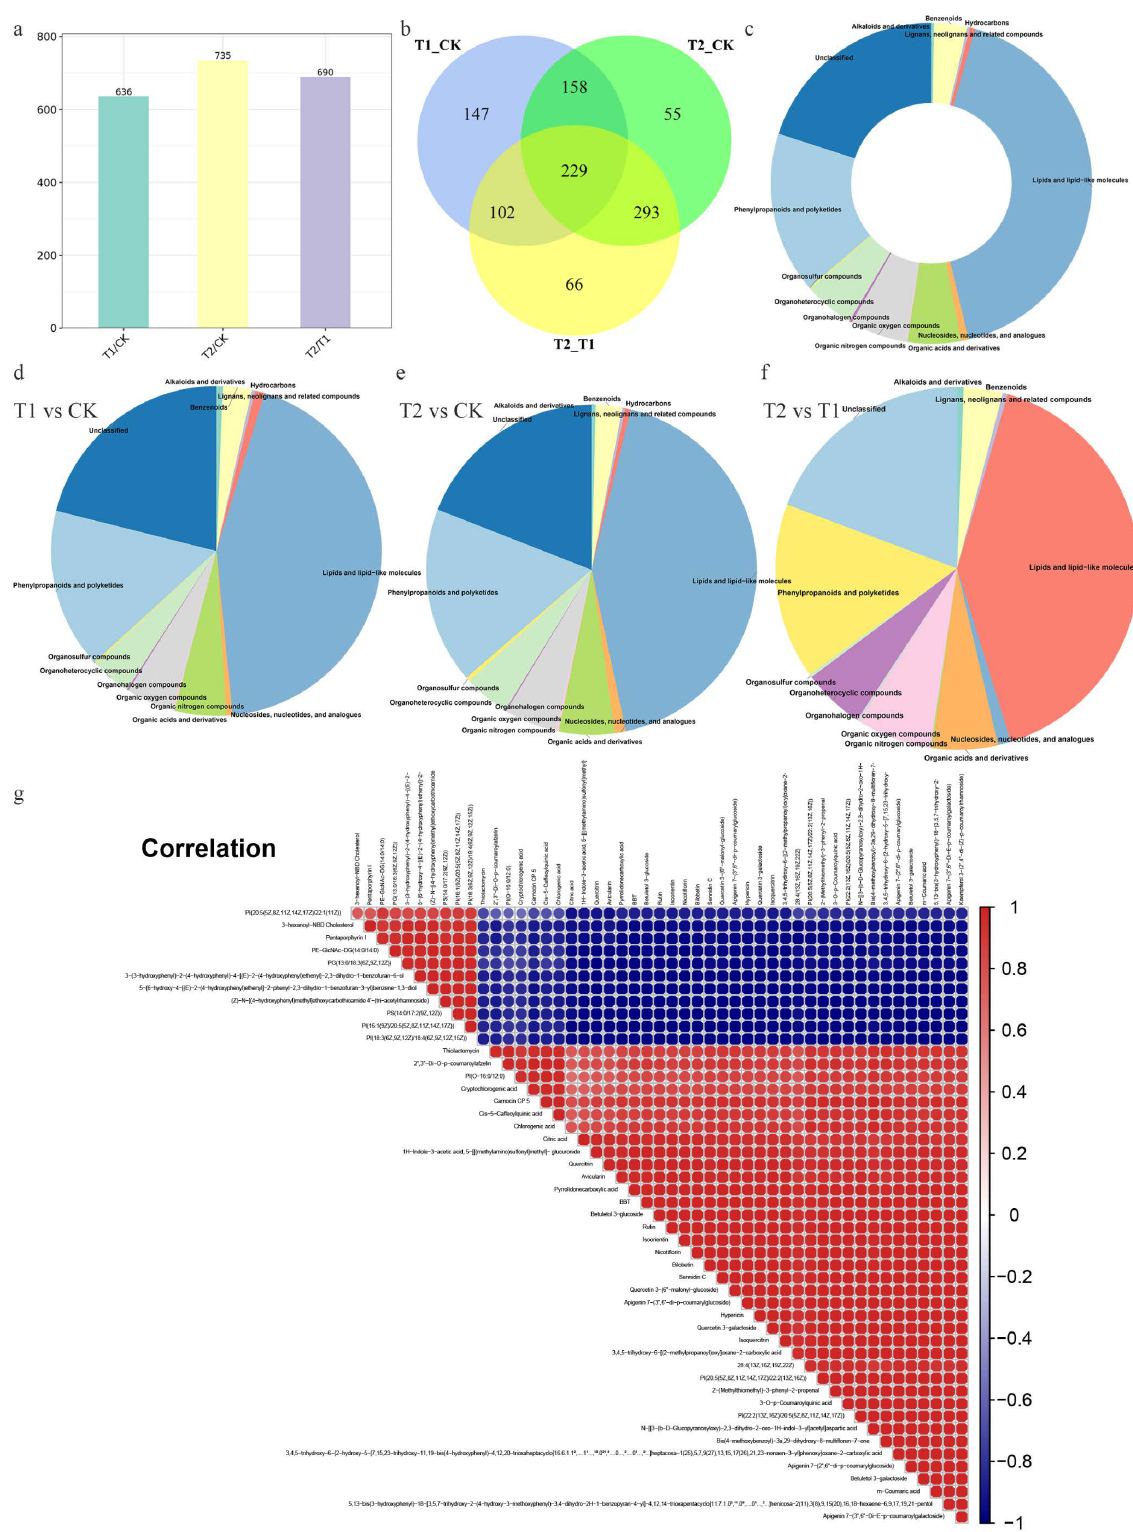
Figure 4. Statistical and analytical charts of differentially expressed metabolites (DEMs). ( a ) DEMs in the different comparisons. ( b ) The number of DEMs in the different comparisons. ( c ) Classification of all DEMs classification. ( d – f ) DEMs in different superclasses between the T1 and CK groups, T2 and CK groups, and T2 and T1 groups, respectively. ( g ) Correlation analysis of the top 50